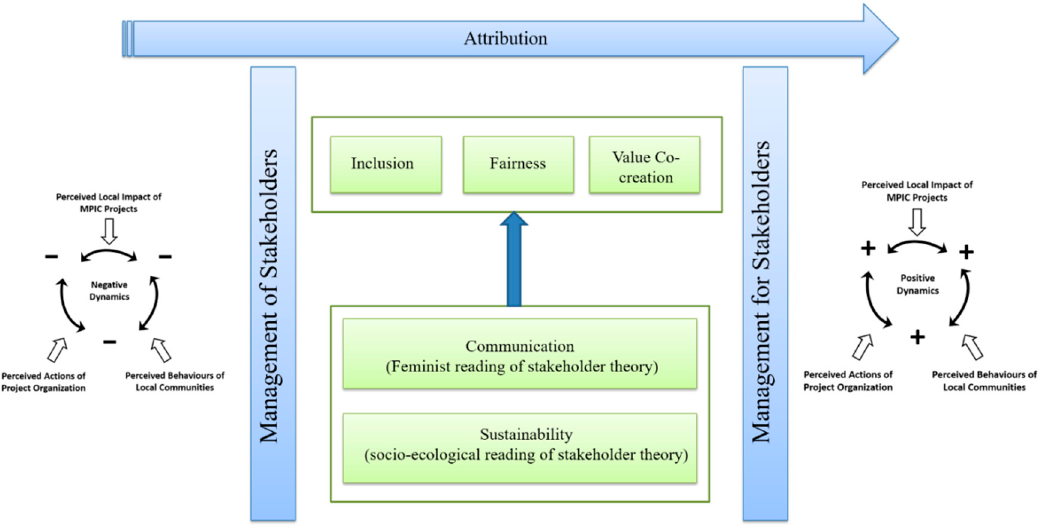
Figure 2. The shift from negative to positive bond.